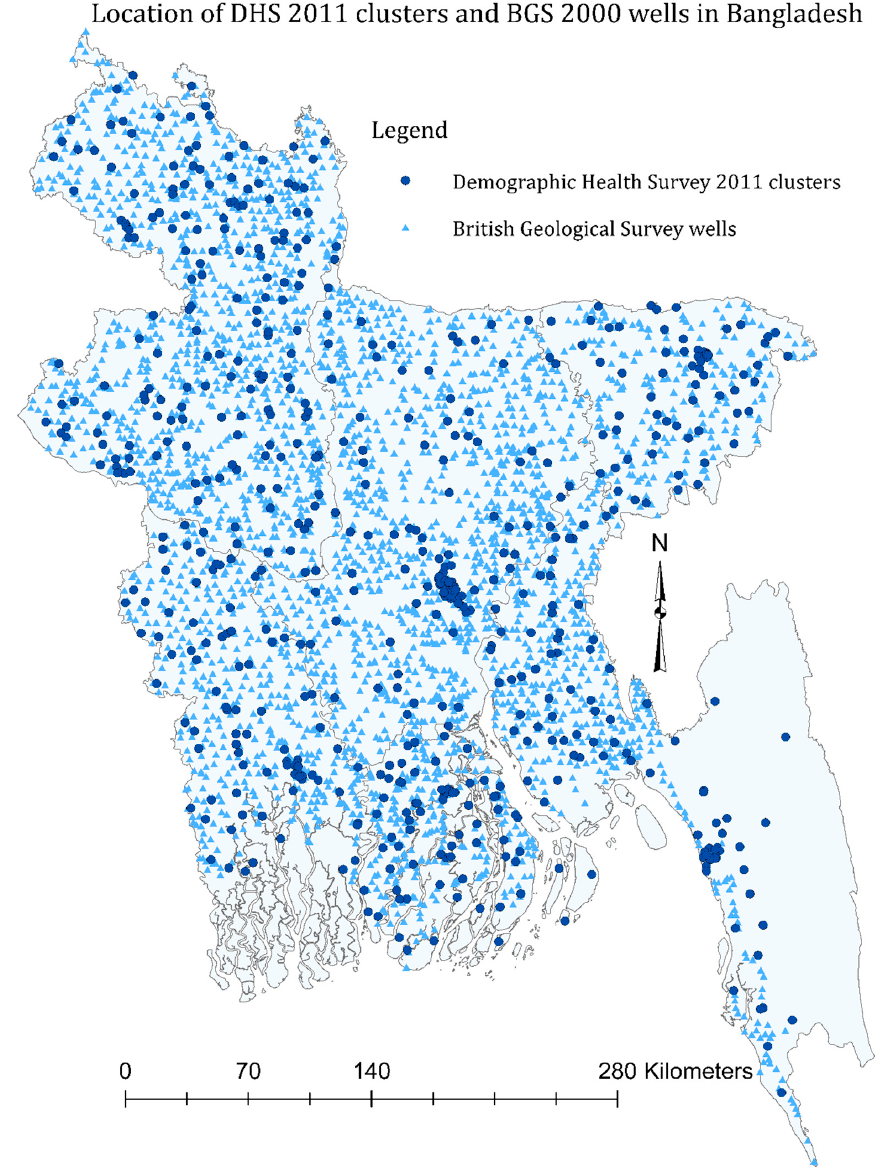
Figure 1. Location of demographic and health survey (DHS) 2001 clusters and British Geological Survey (BGS) 1998-1999 wells in